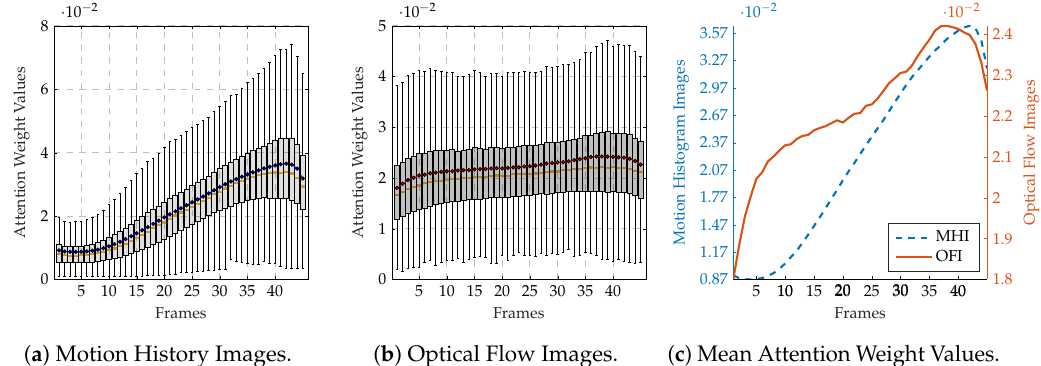
Figure 8. SenseEmotion Database: Attention network weight values for the classification task T 0 vs . T 3 . Within each boxplot in ( a , b ), the mean and the median weight values are depicted respectively with a dot and a horizontal line. In ( c ), the average weight values are normalised between the maximum average value and the minimum average value to allow a better visualisation of the values distributions.